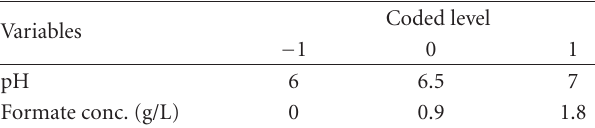
Figure 1: The top of the fermenter unit. Table 1: The codes and levels of the variables used in the exper- imental design.